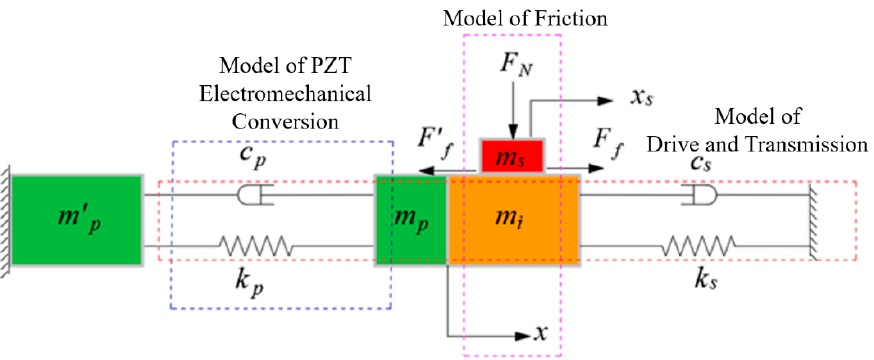
Figure 3. Dynamic model of the nanopositioning stage.